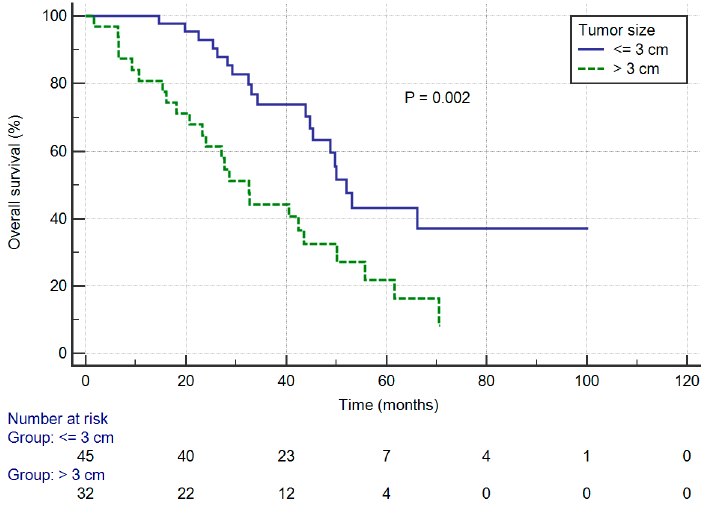
Figure 2. Overall survival curves of patients stratified by tumor size.